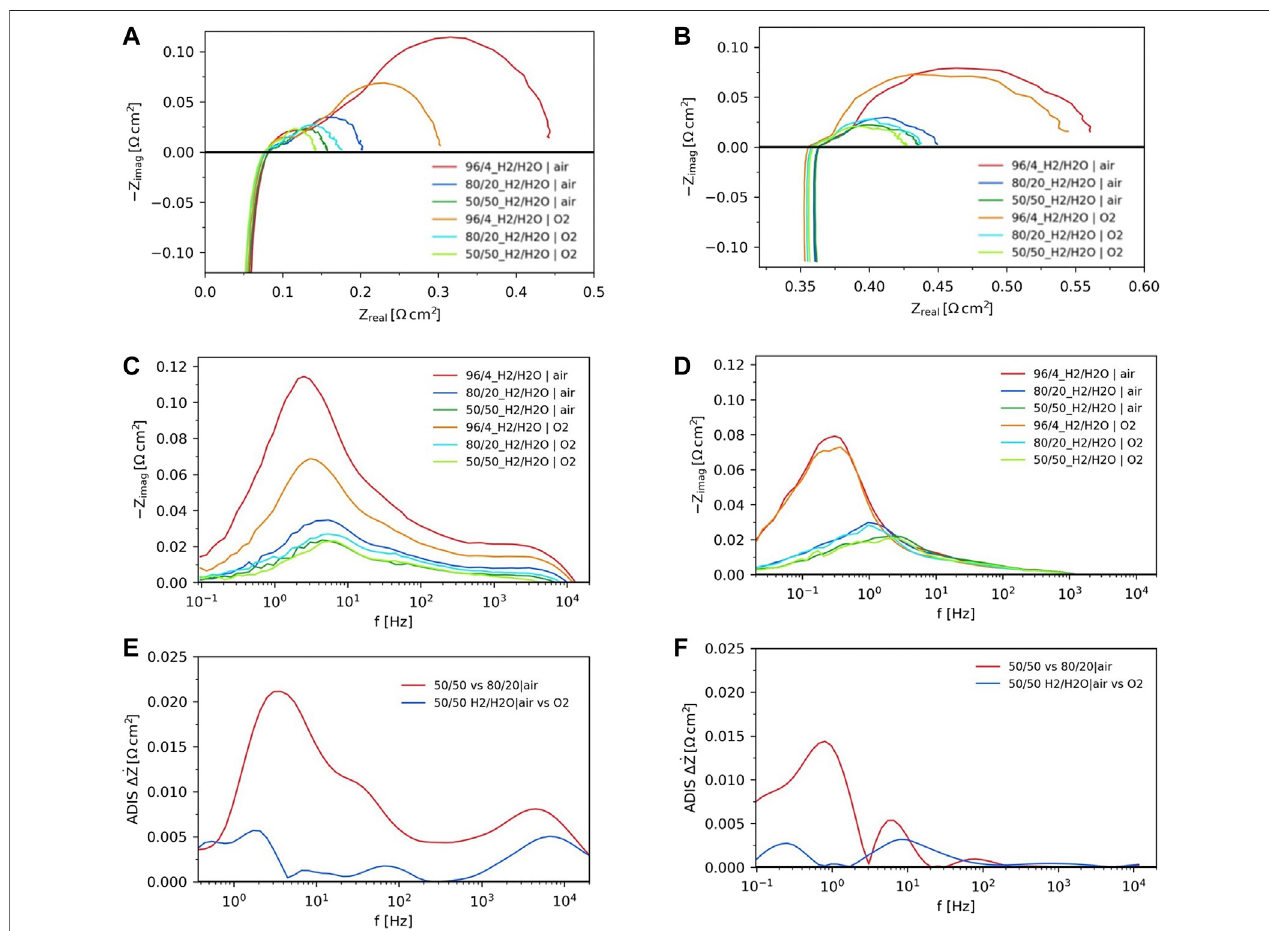
FIGURE 3 | Nyquist and Bode plots under different H 2 /H 2 O ratios with variation of oxygen partial pressure at 850 ° C for ASC con fi guration (A,C) and ESC con fi guration (B,D) , evaluation of dependences on fuel and oxidant composition through ADIS for ASC (E) and ESC (F) .